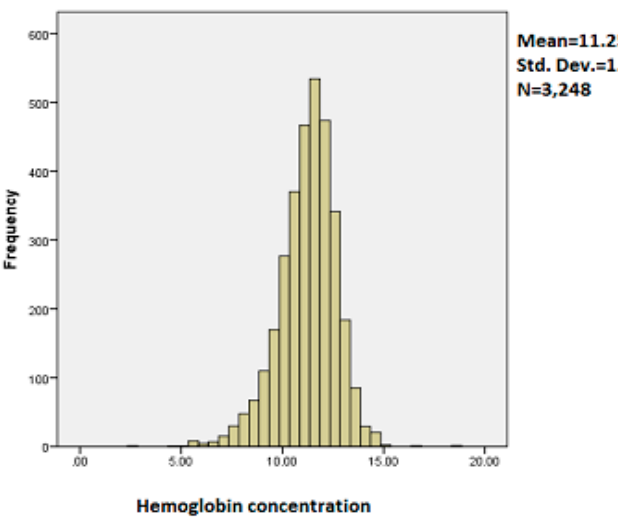
Figure 1. Histogram of childhood hemoglobin concentration.